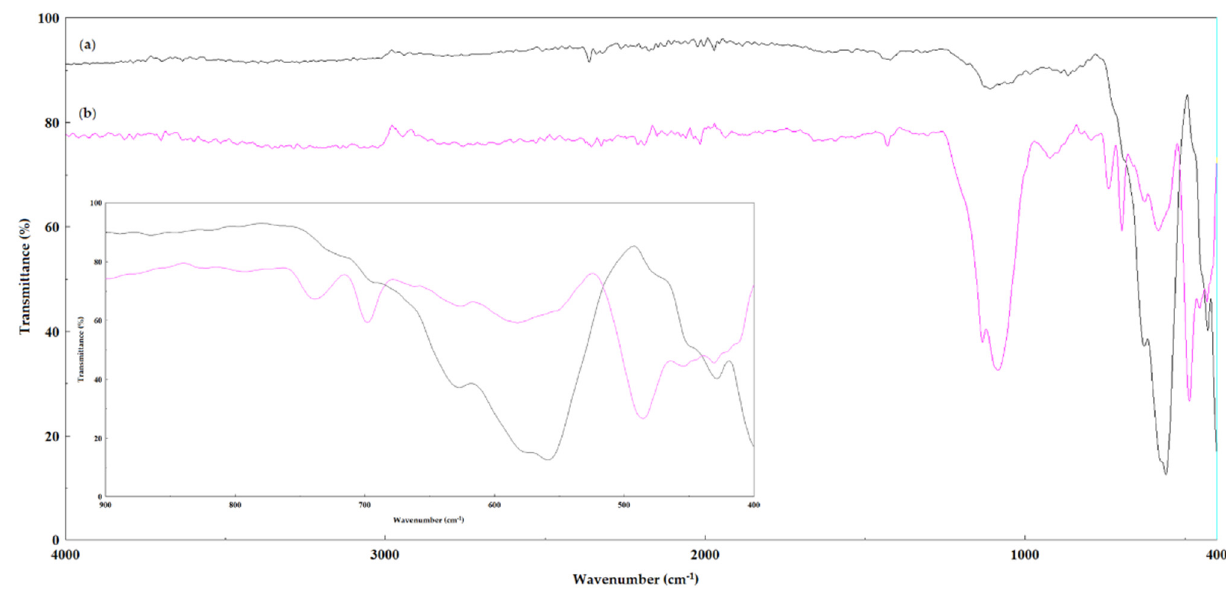
Figure 7. FT-IR spectra of: ( a ) magnetic support MP1 and ( b ) cellulase biocatalyst (M1-SG9), which were obtained by the magnetic sol–gel immobilization method with silane precursors VTMOS: PhTMOS:TMOS (0.4:1.6:1) and MP1. Inset: enlarged picture of the 400–900 cm − 1 region, showing the presence of the specific absorption bands for the magnetite/maghemite mixture.